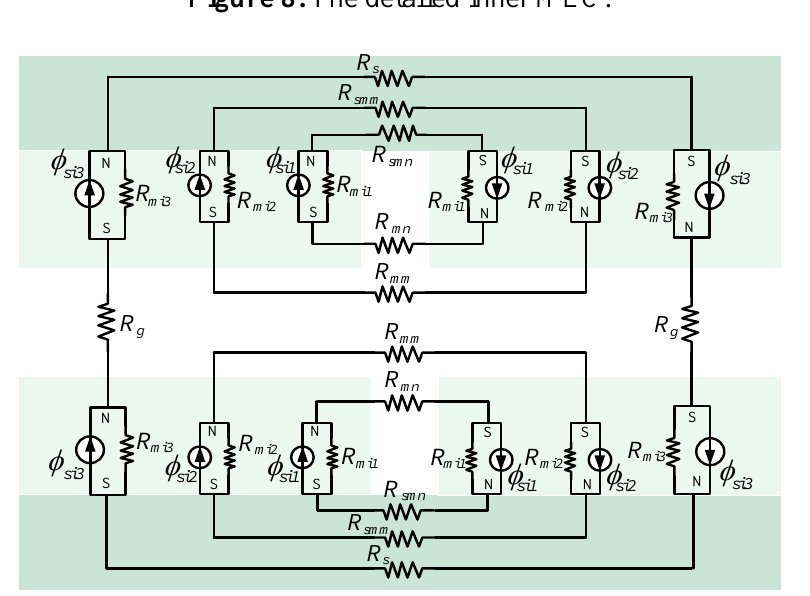
Figure 8. The detailed inner